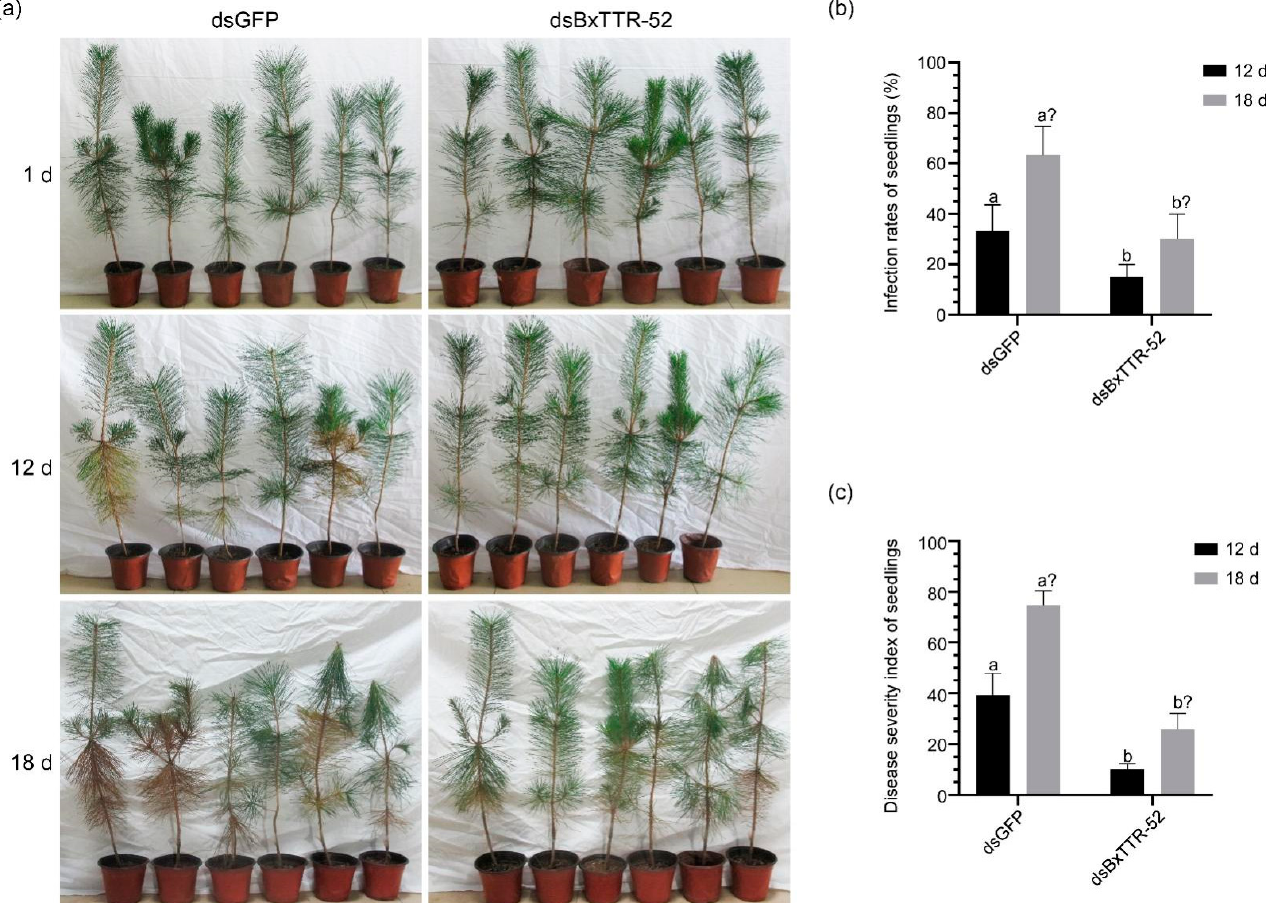
Figure 5. BxTTR-52 contributes to Bursaphelenchus xylophilu s virulence. ( a ) Inoculation assay of pine seedlings. Based on the color of the needles, the morbidity degree of the Pinus thunbergii seedlings was different. The seedlings inoculated with dsGFP -treated nematodes were the negative controls. ( b ) The infection rates of P. thunbergii seedlings under three different treatments. ( c ) The disease severity index of P. thunbergii seedlings under three different treatments. Values represent the means ± SD of three independent biological samples. Different letters on top of the bars indicate statistically significant differences ( p < 0.05, t -test) as measured by Duncan’s multiple range